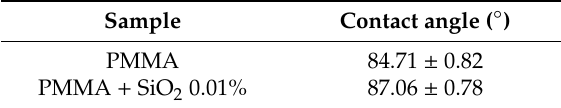
Figure 9. Water contact angle measurements performed on PMMA and PMMA + SiO 2 0.01%. Table 4. Values of the contact angle for the PMMA coatings.